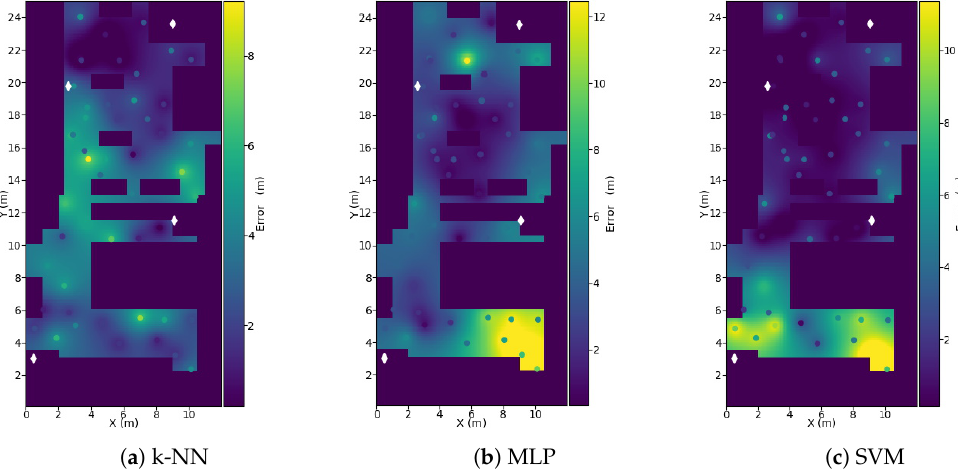
Figure 6. Error map of the three fingerprint-based methods in Environment